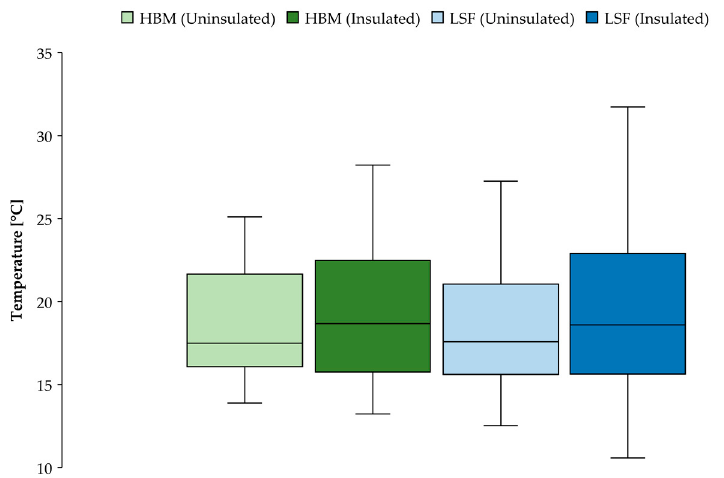
Figure 7. Annual box plot representation of the indoor temperature obtained experimentally: unin- sulated vs insulated ground